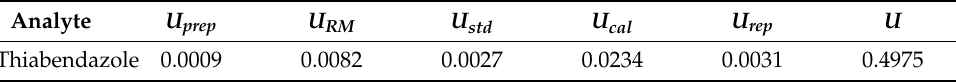
Table 6. Individual uncertainties of the sample preparation ( U prep ), reference material ( U RM ), standard stock solution ( U std ), calibration curve ( U cal ), repeatability ( U rep ), and expanded uncertainty ( U ) according to the EURACHEM